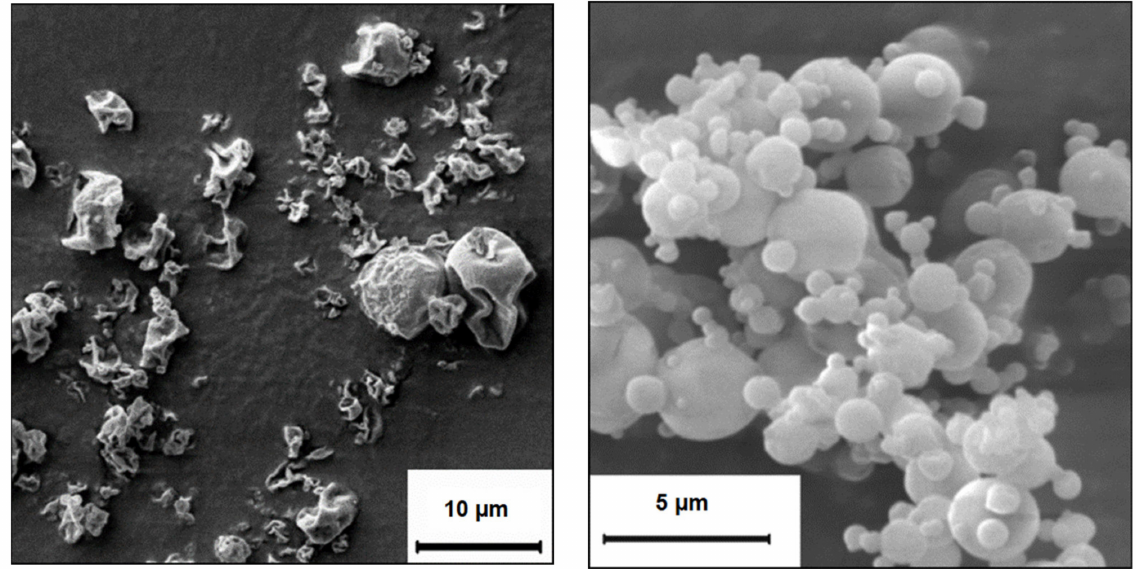
Figure 3. SEM pictures of spray dried powder. Left : PLGA nanoparticles loaded with OVA prepared by solvent change evaporation and 0.5% HPMC as stabiliser/matrix. Right : PLGA nanoparticles with OVA prepared by the double emulsion technique and 1% PVA as